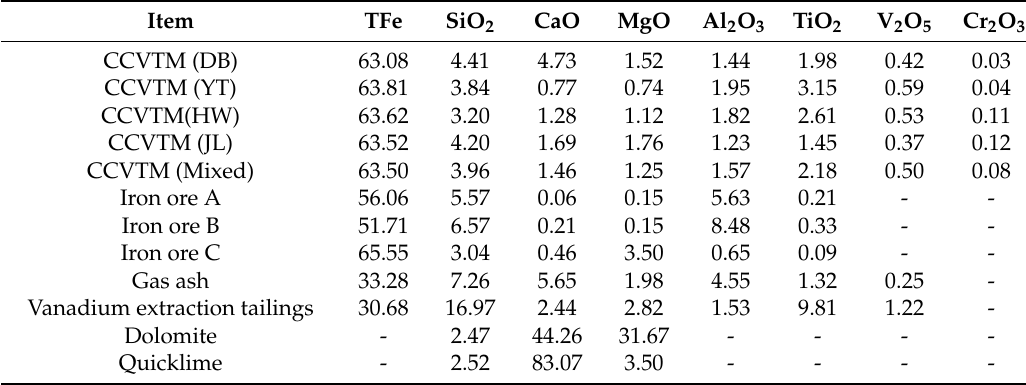
Table 1. Chemical compositions of the raw materials (mass